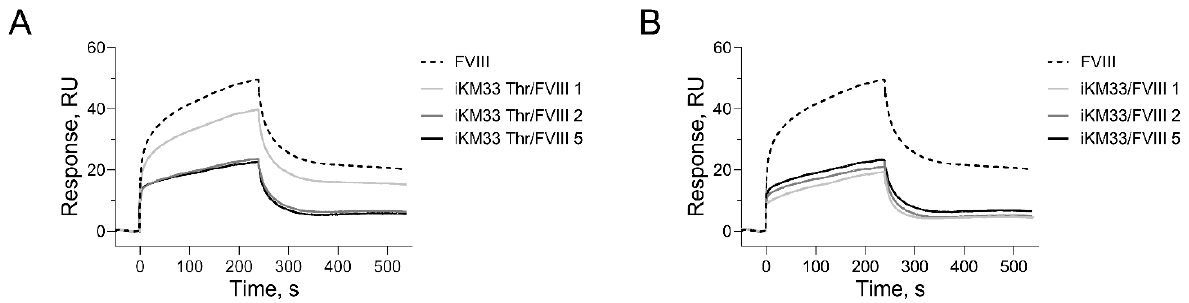
Figure 7. Effect of thrombin-cleaved iKM33-v2 on the binding of FVIII to LRP1. In SPR assay, LRP1 was immobilized on a chip via amine coupling and tested for binding with FVIII (100 nM) preincubated without or with iKM33-v2 at a ratio of 1, 2, or 5 ( A ). In a similar set-up, immobilized LRP1 was tested with thrombin-cleaved iKM33-v2 (reaction was terminated by PPACK and confirmed for cleavage by SDS-PAGE) ( B ). Both experiments were repeated three times with similar results.